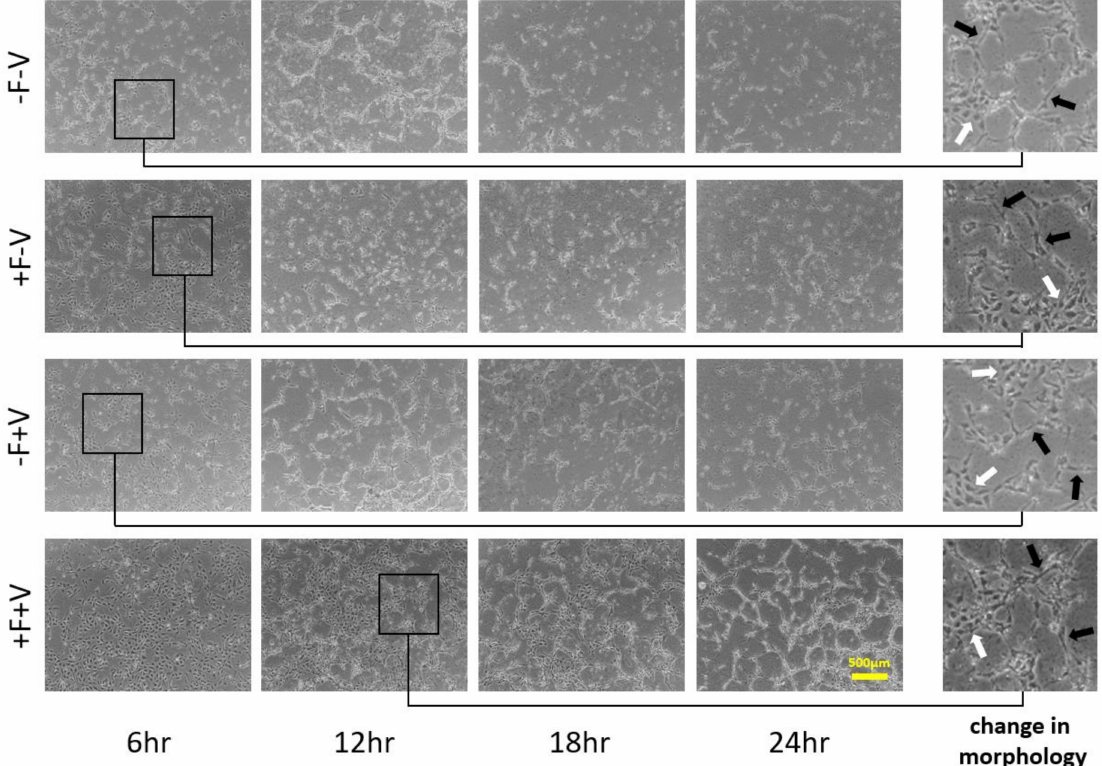
Figure 2. HUVECs morphological forms and cellular networks in different cell culture conditions: without fibronectin ( − F), with fibronectin (+F), without VEGF ( − V), and with VEGF (+V). Black arrows in the enlarged photos indicate the cells with morphological change into the elongated shape, while white arrows indicate the cells still in the original cobblestone